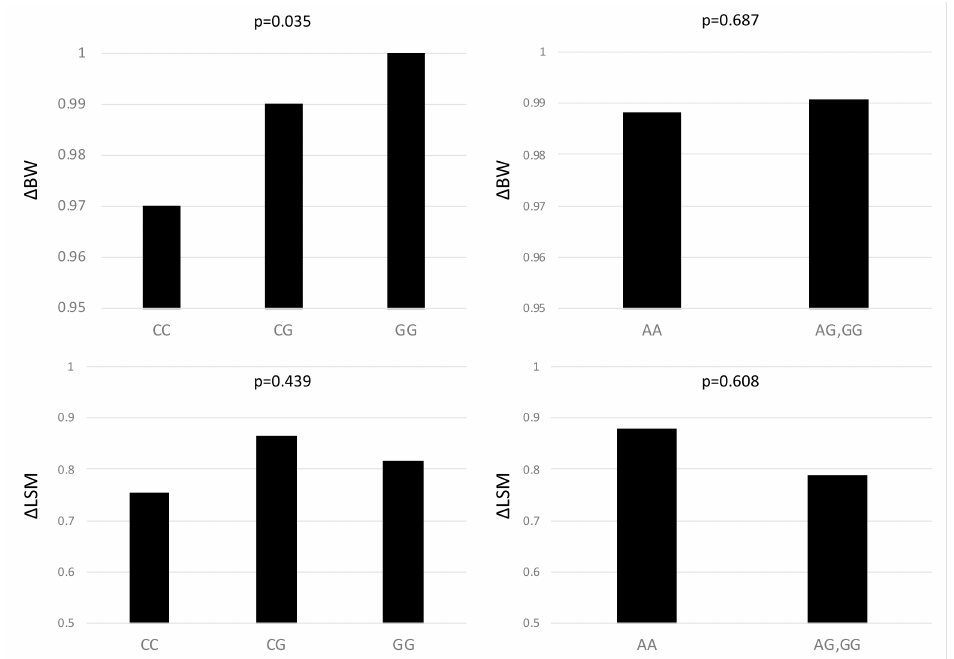
Figure 1. The changes in body weight and liver stiffness measurement according to PNPLA3 rs738409 genotypes and HSD17B13 rs6834314 in 140 patients with non-alcoholic fatty liver disease.